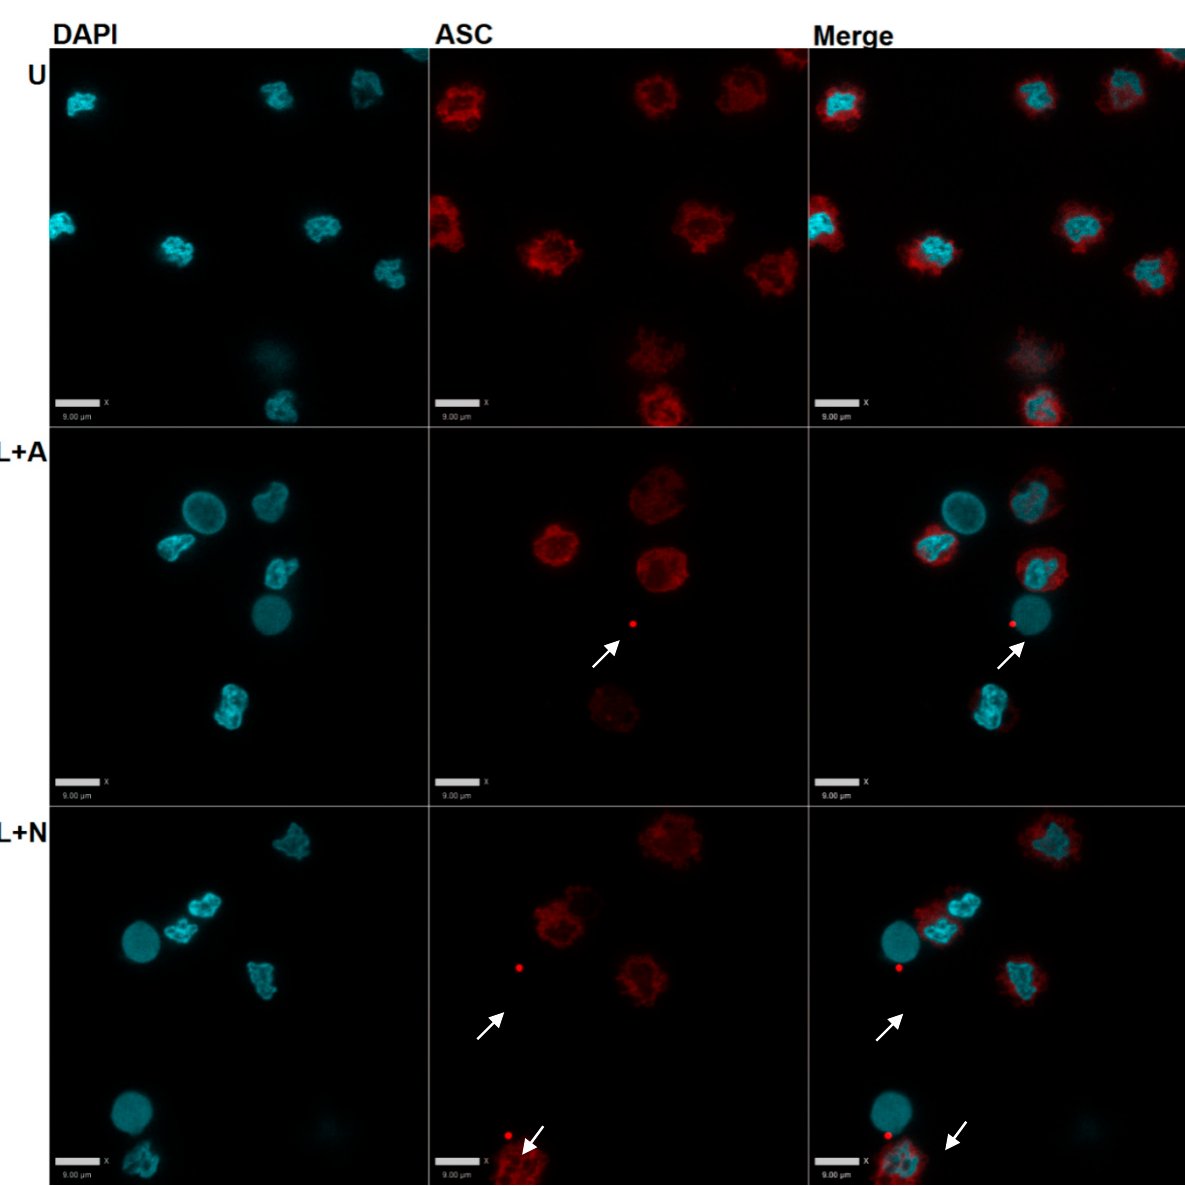
Figure 2. Photomicrographs of PBMC with ASC specks (shown with arrows). Visible ASC specks form when PBMC are treated with NLRP3 inflammasome activators. Scale bar, images were not zoomed or cropped = 9 µ m. U—unstimulated; L—LPS; A—ATP; N—Nigericin. Images captured at 63X objective lens